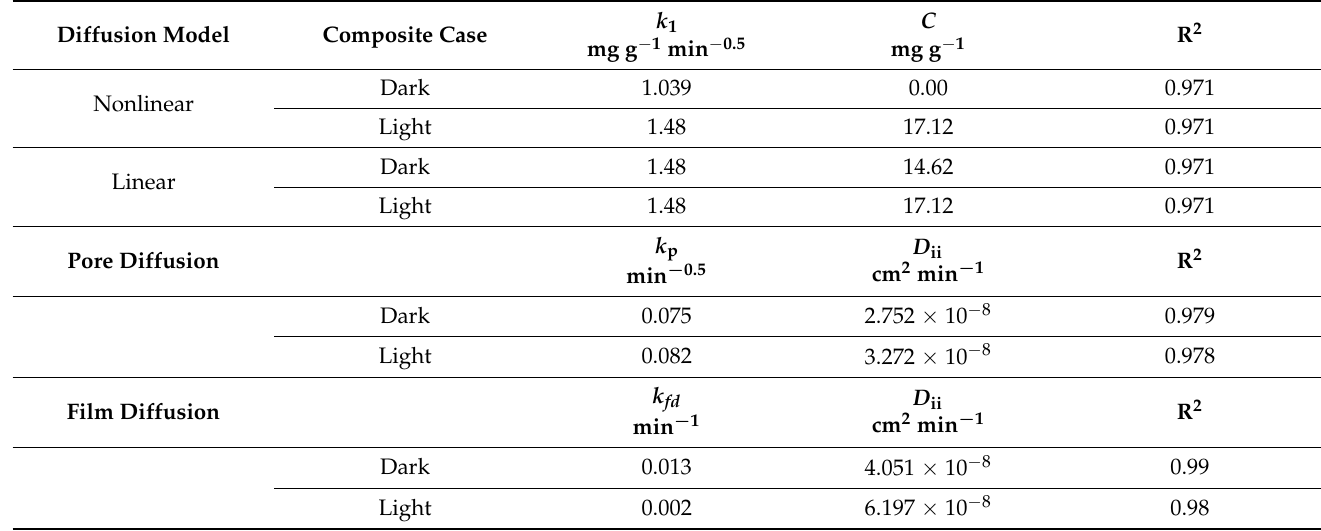
Table 3. Diffusion